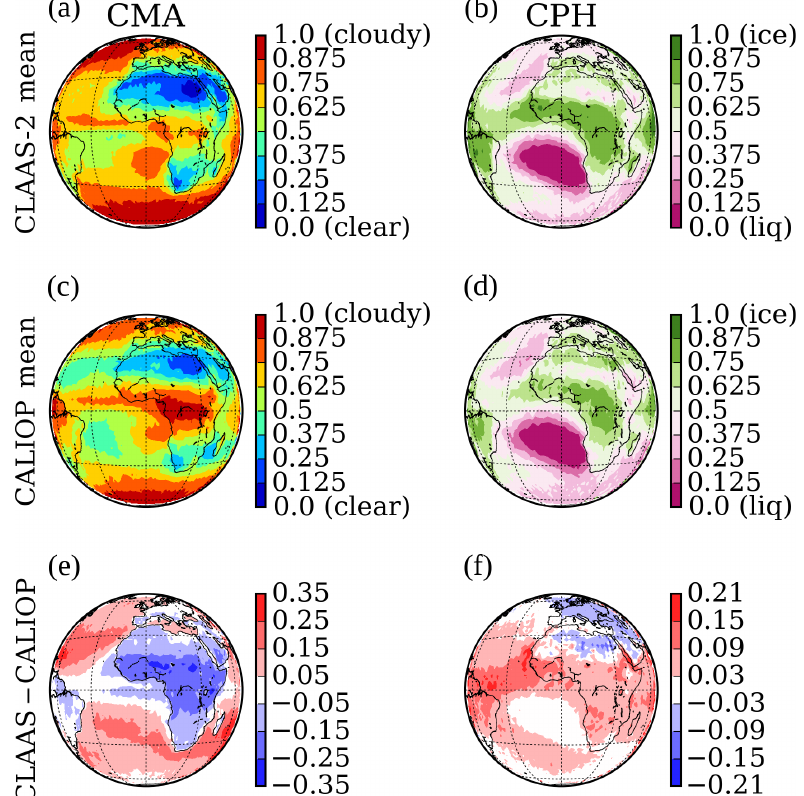
Figure 2. Spatial distribution of the cloud fraction from CLAAS-2 level 2 (a) and CALIOP (c) and the fraction of ice clouds ( b and d ). The bottom row shows the absolute difference in CLAAS and CALIOP for the cloud fraction (e) and the fraction of ice clouds (f) . Note the different scaling in (e) and (f) . The CALIOP cloud detection criterion is total column COT > 0, while the CALIOP phase is taken from the layer at which ICOT exceeds